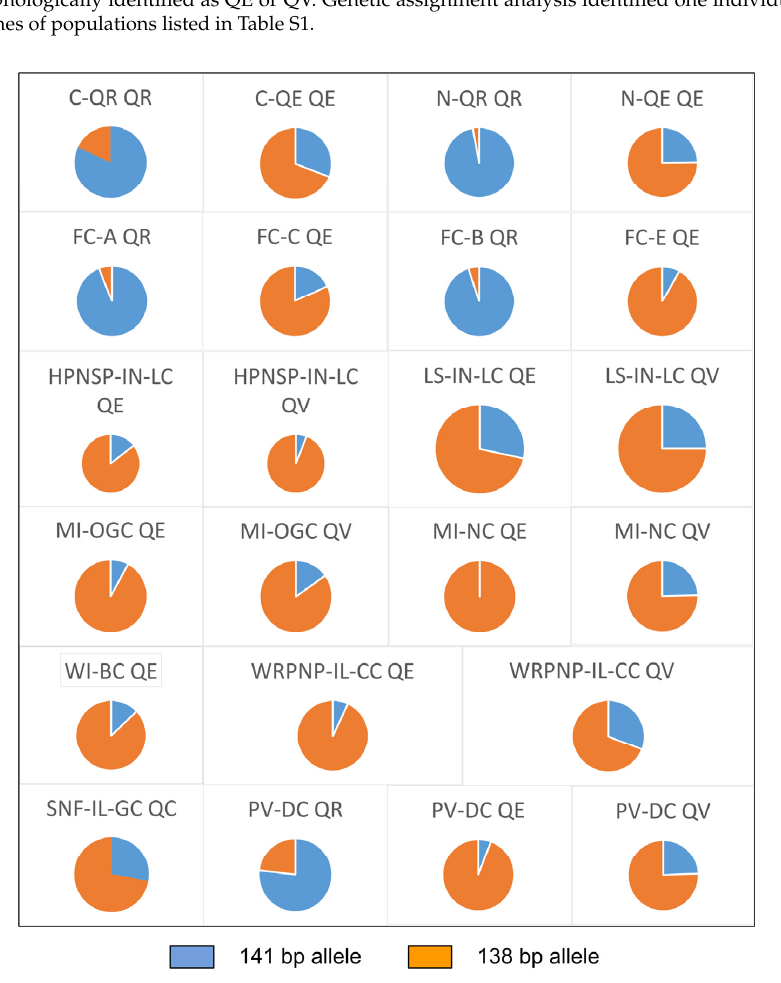
Figure 4. FIR013 allele frequencies in each population separated by species. Orange represents the 138 bp allele and blue represents the 141 bp allele. Full names of populations listed in Table S1. Table 3. Relative frequency of hybrids and introgressive forms *.